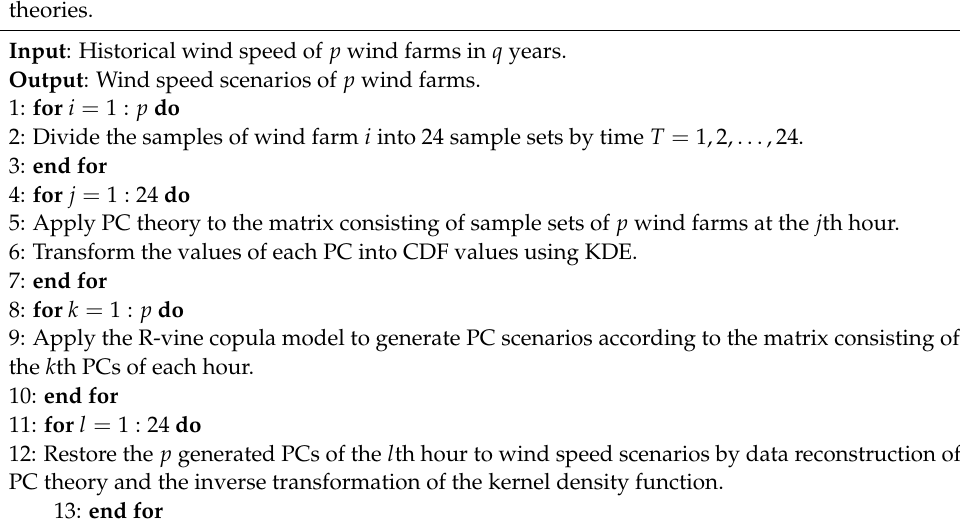
Algorithm 1 Mixed method to generate wind speed scenarios based on PC and R-vine copula